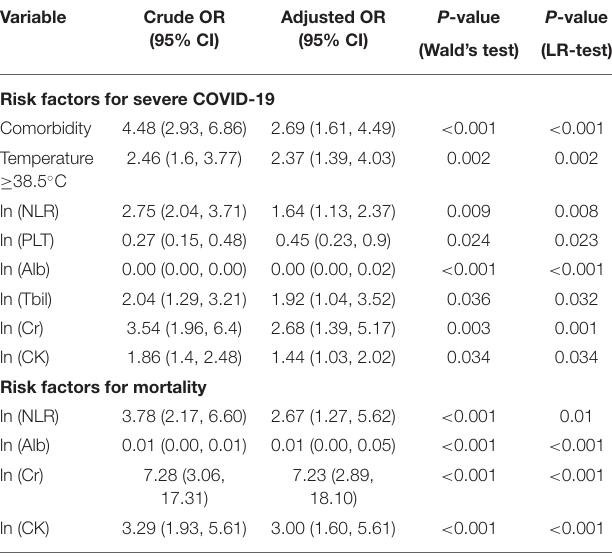
TABLE 3 | Risk factors for severe COVID-19 and mortality.